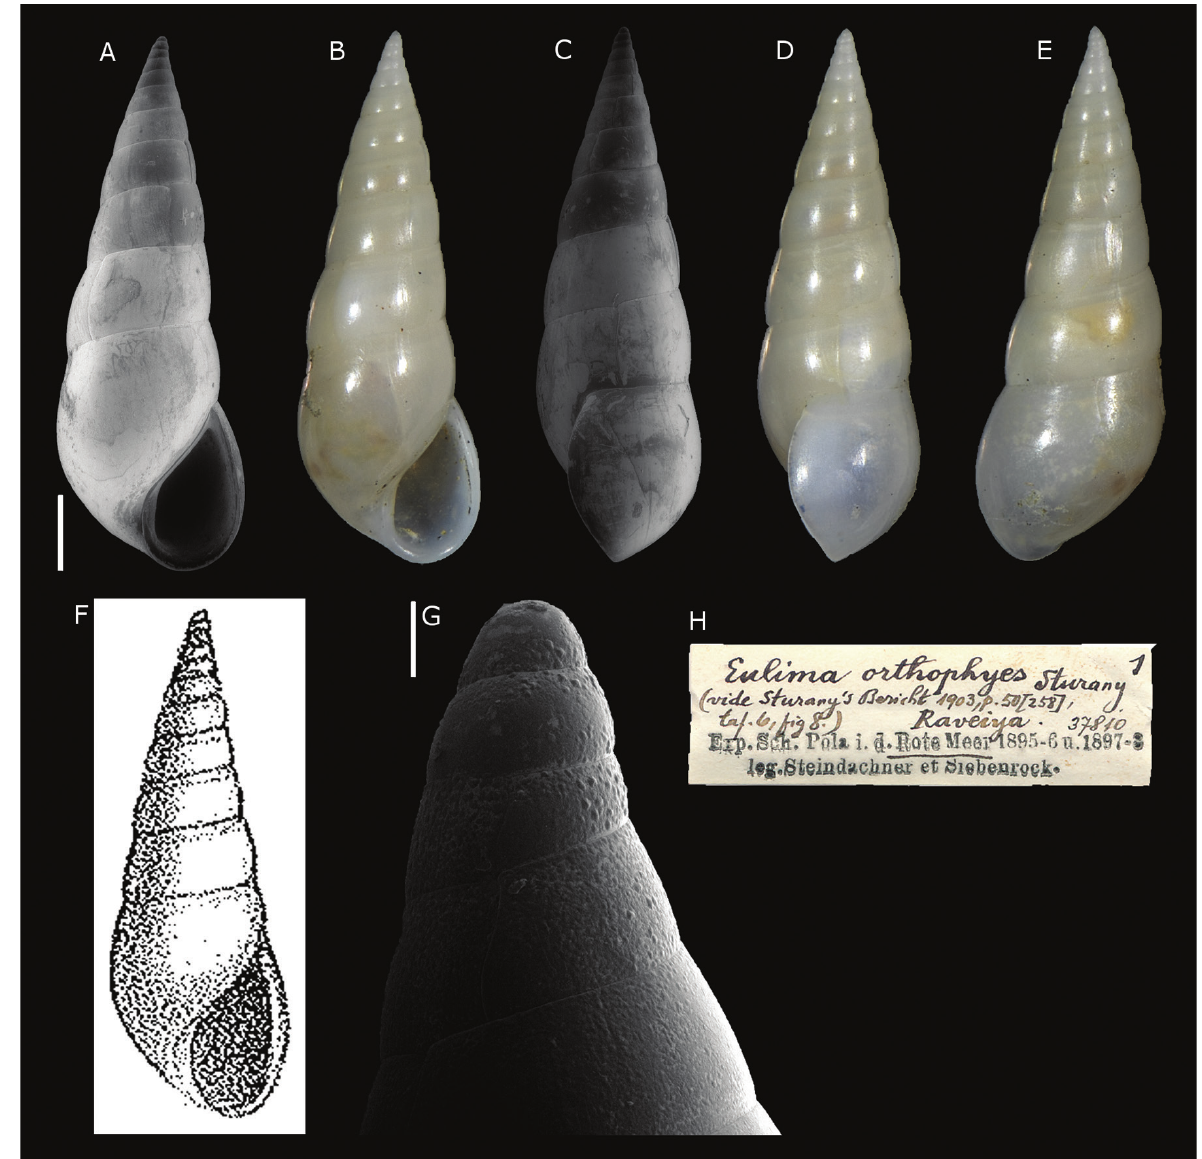
Figure 6. Eulima orthophyes Sturany, 1903, Locality 32 (Gul Mohammad, Saudi Arabia, Red Sea). A–E, G . Holotype, NHMW 37810: front ( A–B ), right side ( C–D ), back ( E ), protoconch ( G ). F . Original figure by Sturany (1903). H . Original holotype label. Scale bars: A–E : 1 mm, G : 0.1 mm.